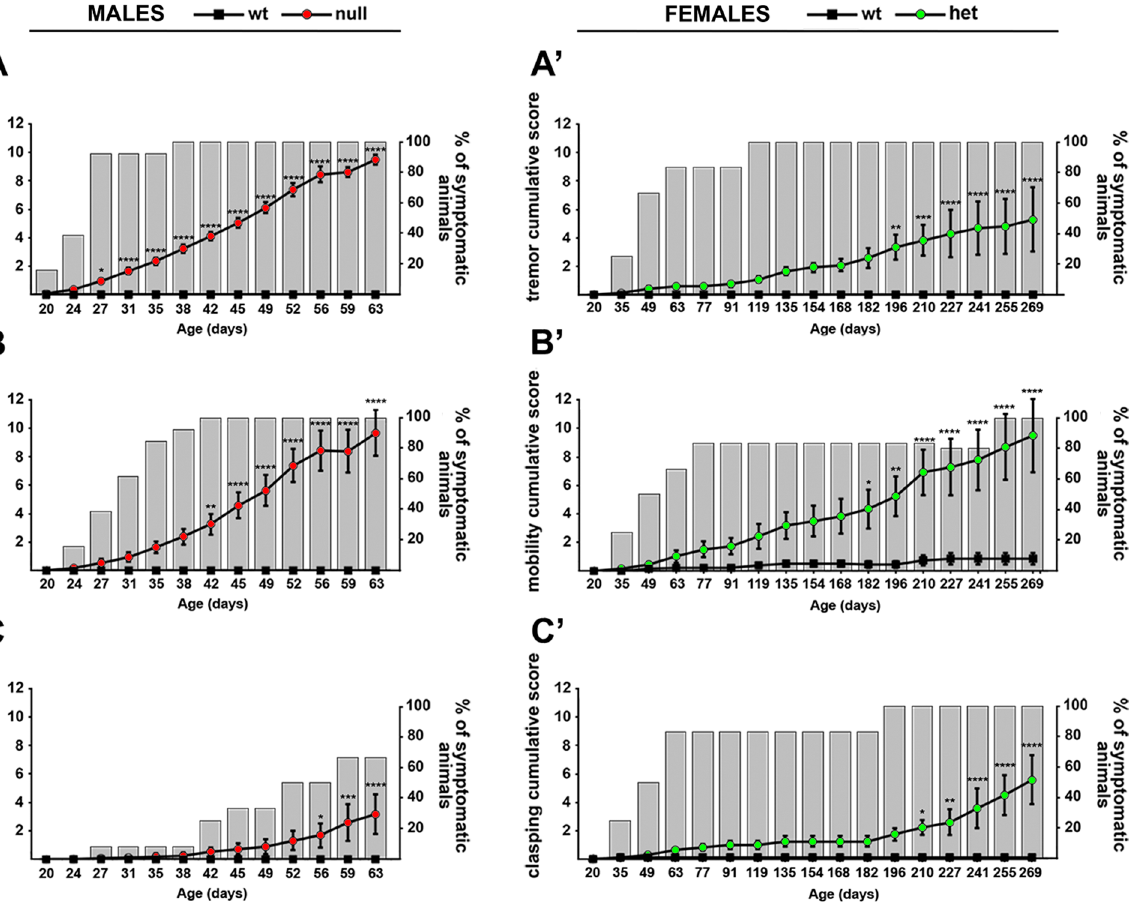
Fig 2. Phenotypic characterization of the CD1 Mecp2 -null male and Mecp2 +/- female mice. The presence of symptoms (tremor ( A-A ’ ), mobility ( B-B ’ ) and clasping ( C-C ’ )) was evaluated in null ( A , B , C ) and heterozygous animals ( A ’ , B ’ , C ’ ) starting from P20. Continuous lines represent the evolution of the symptomatology, while histograms represent the percentage of null or heterozygous animals displaying the symptom at any given age. Statistical significance was evaluated through two-way ANOVA, Bonferroni ’ s post-hoc test: * = p < 0,05; ** = p < 0,01; *** = p < 0,001; **** = p < 0,0001; n = 15 wt males, 13 Mecp2 -null, 7 Mecp2 +/- and 7 wt